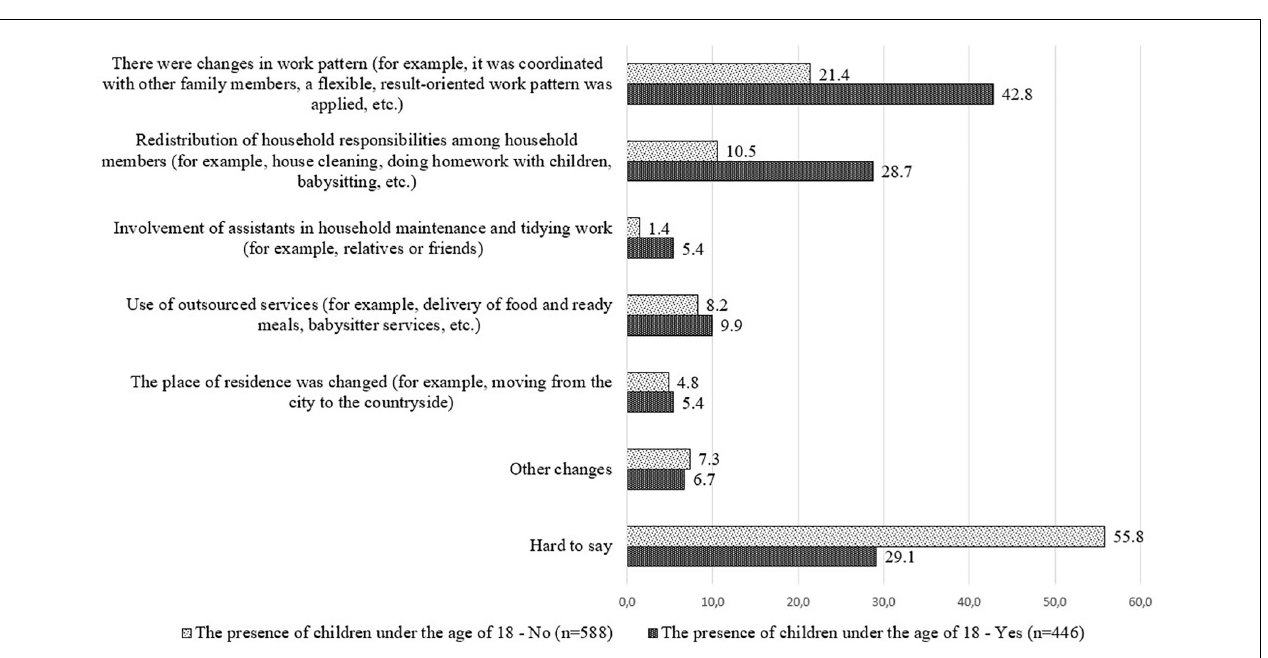
old; statistical significance index p = 0.045 ( ≤ 0.05)—between the age groups of respondents who are 25–34 and 35–44 years old; and p < 0.001 ( ≤ 0.05)—between the age groups of respondents who are 35–44 and 55–63 years old. There are no